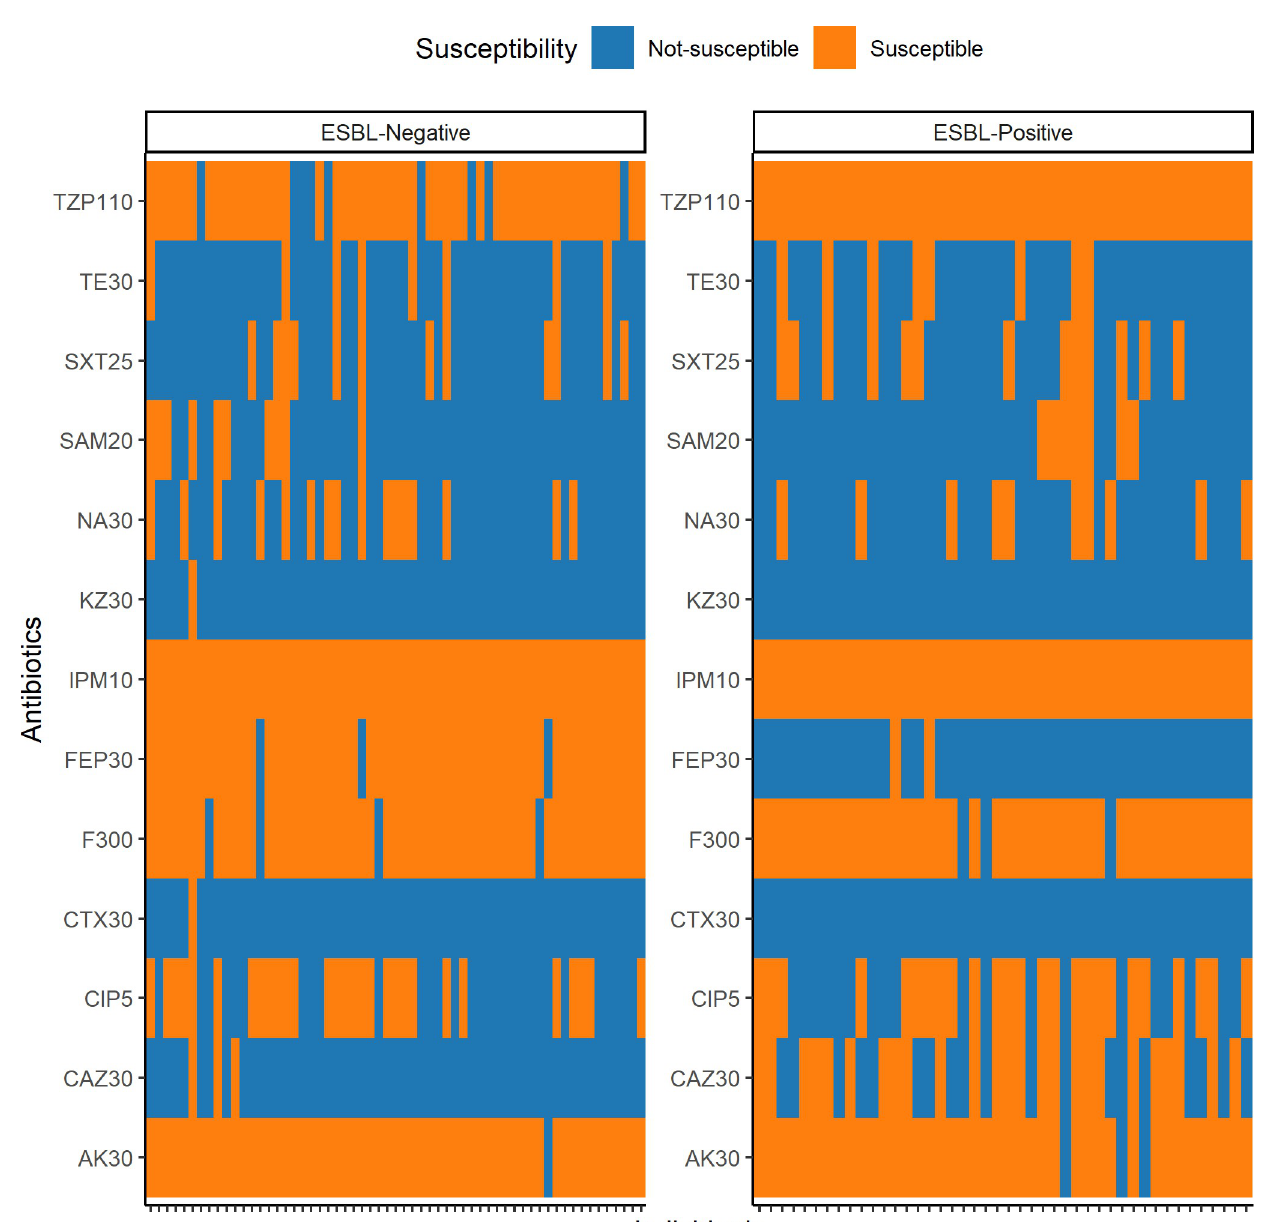
Fig 1. Antibiotic susceptibility profile of independent Escherichia coli isolated from Segamat community dwellers against 13 antibiotics, sorted based on ESBL phenotype. Abbreviations: TZP110 = Piperacillin-Tazobactam (110 μ g); TE30 = Tetracycline (30 μ g); SXT25 = Sulfamethoxazole-Trimethoprim (25 μ g); SAM20 = Ampicillin-Sulbactam (20 μ g); NA30 = Nalidixic Acid (30 μ g); KZ30 = Cefazolin (30 μ g); IPM10 = Imipenem (10 μ g); FEP30 = Cefepime (30 μ g); F300 = Nitrofurantoin (300 μ g); CTX30 = Cefotaxime (30 μ g); CIP5 = Ciprofloxacin (5 μ g); CAZ30 = Ceftazidime (30 μ g); AK30 = Amikacin (30 μ